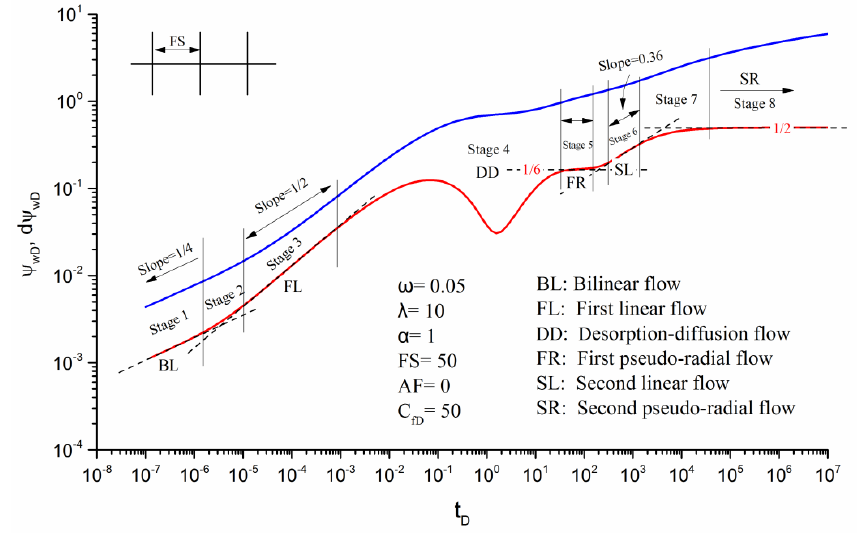
Figure 4. The typical pseudo-pressure curves for a multi-fractured horizontal well in a coalbed methane (CBM) reservoir.